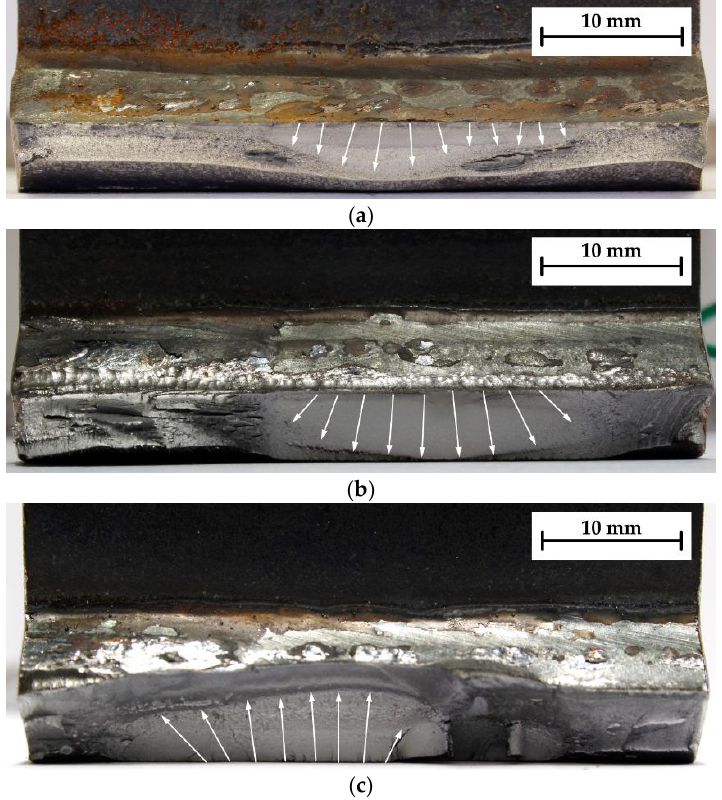
Figure 9. Fracture surface examples. ( a ) Crack initiation at weld toe in as-welded condition, ( Δσ N = 600 MPa, N = 38.765); ( b ) Crack initiation at weld toe in HMFI-treated condition, ( Δσ N = 400 MPa, N = 826,530); ( c ) Crack initiation at base material just below the weld in HMFI-treated condition, ( Δσ N = 600 MPa, N = 44,582).